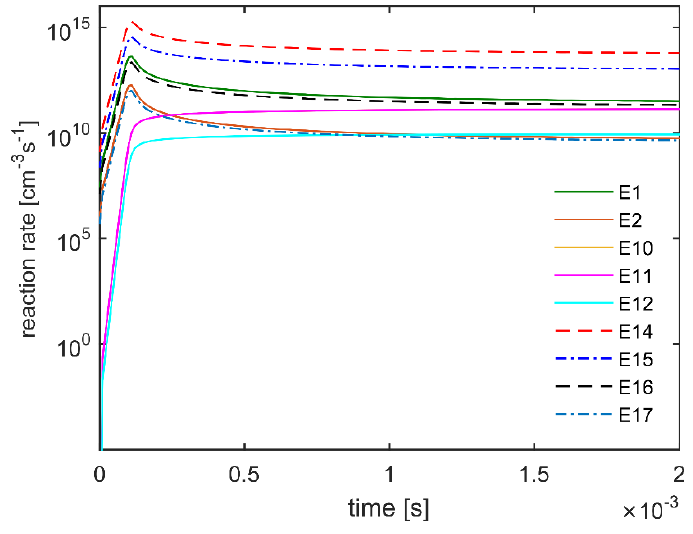
Figure 8. Reaction rates predicted by ZDPlasKin.